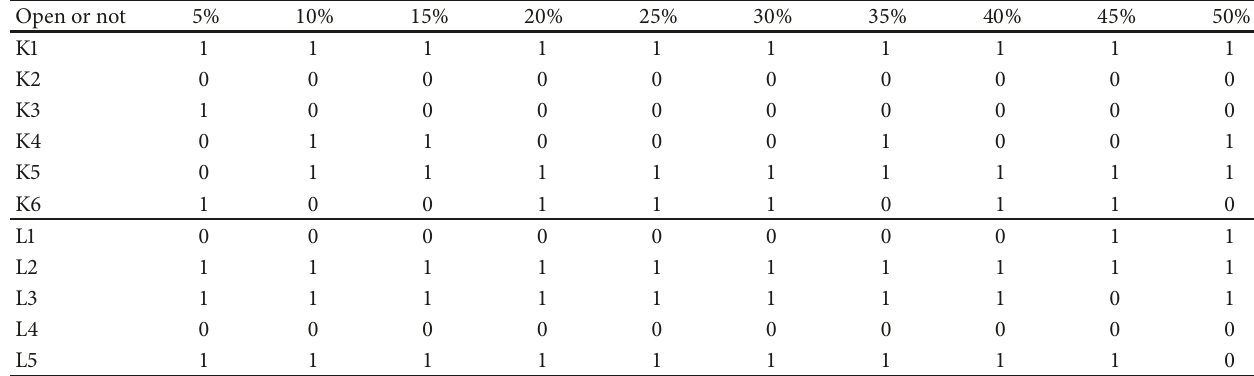
Table 15: Impact of fixed cost coefficients’ variance on choice of opening sites.